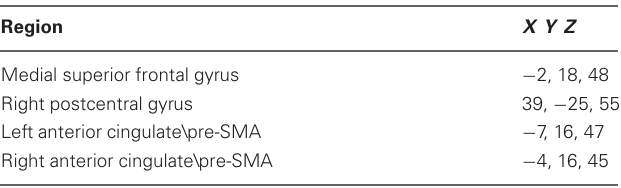
Table 3 | Regions related to the different levels of source of planning (IGAP vs.